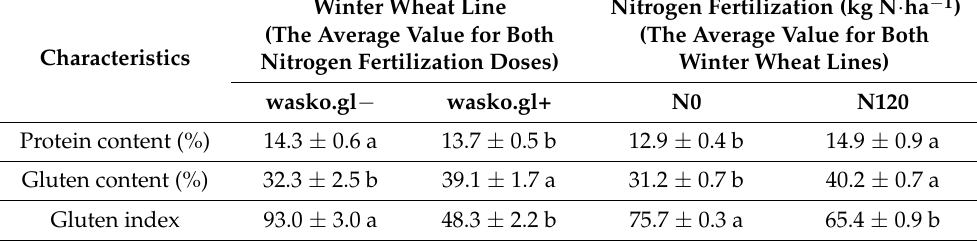
Table 2. Estimated values of protein and gluten content (%) and gluten index depending on main factors: winter wheat lines and nitrogen fertilization doses. The second column shows the average values of the parameters listed in the first column, obtained for each of the wheat lines, and for both N doses (0 and 120 kg N · ha − 1 ). The third column shows the average values of the parameters listed in the first column, obtained for each N doses, and for both tested wheat lines (wasko.gl+ and wasko.gl −